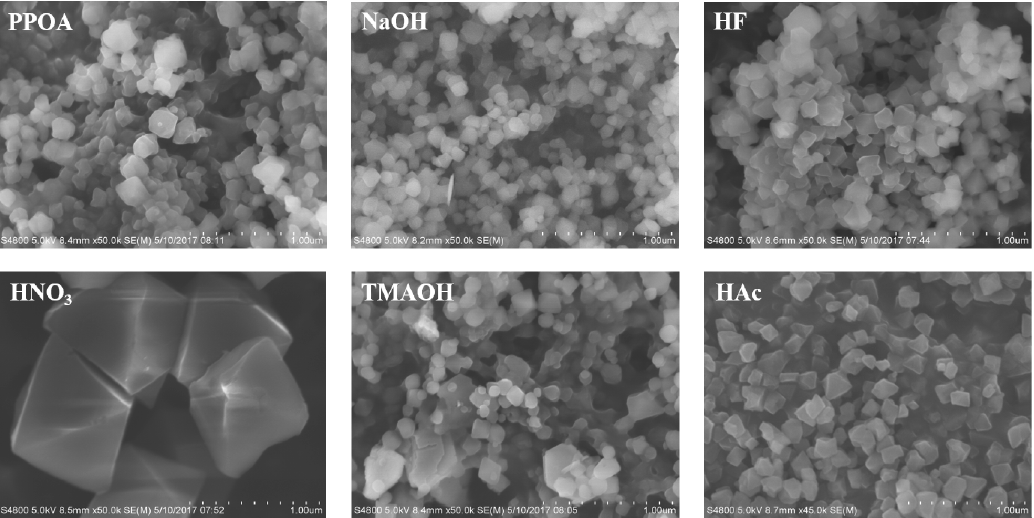
Figure 1. SEM images of MIL-101(Cr)s with various modulators in the synthesis, all the images with the same magnification and the scale bar is 1 μ